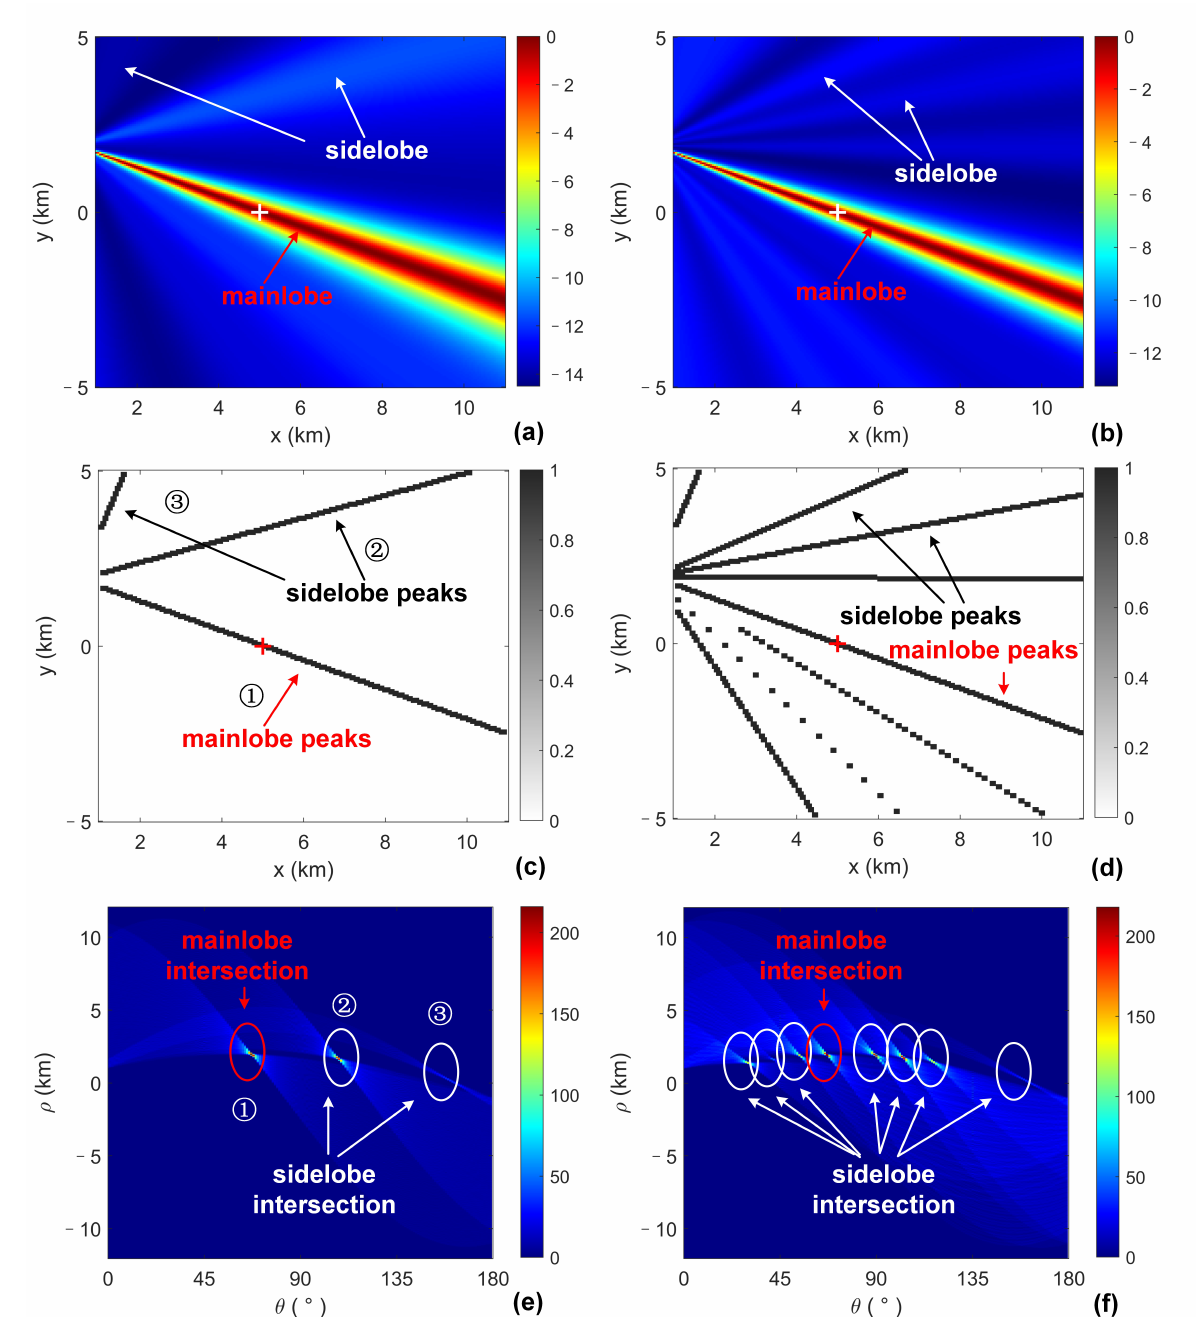
Figure 4. (Color online) ( a , b ) Narrowband SRP maps of 112 Hz and 176 Hz of array 1; ( c , d ) Narrow- band Peak Distribution (PD) patterns of 112 Hz and 176 Hz of array 1; ( e , f ) Narrowband accumulating matrices of 112 Hz and 176 Hz of array 1. The white or red plus markers indicate the true position of the